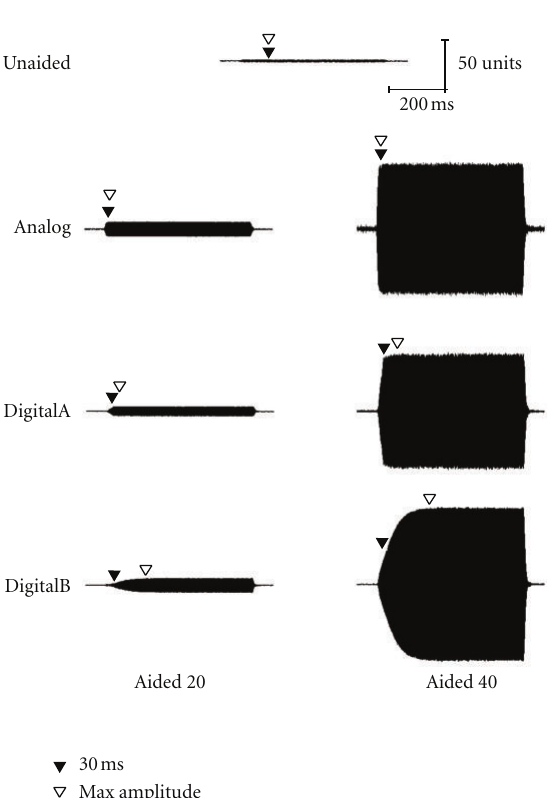
Figure 4: Waveform of the long stimulus presented at 30dB SPL as measured in the ear canal of a single representative subject (subject